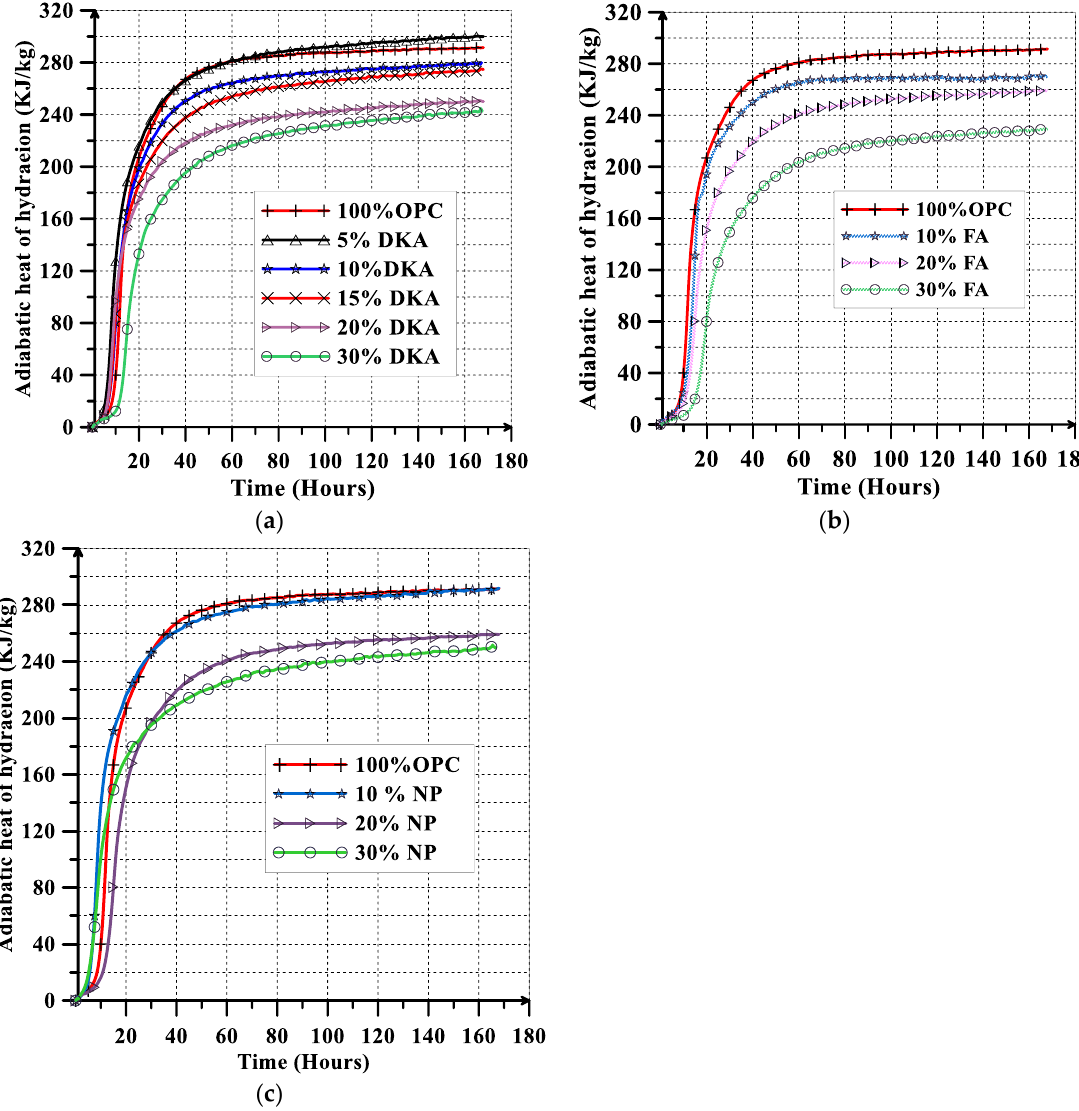
Figure 16. Adiabatic heat of hydration rise versus time for ( a ) DKA, ( b ) FA, and ( c ) NP.